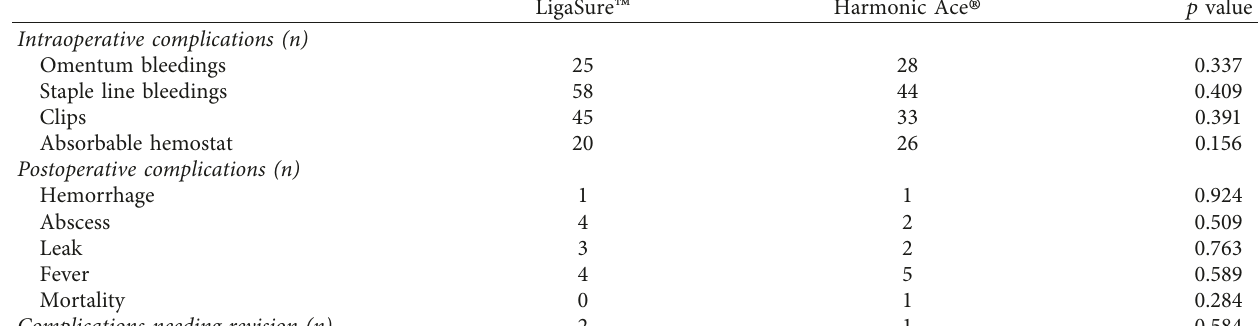
Table 2: Intraoperative and perioperative complications of the patients who underwent laparoscopic sleeve gastrectomy with LigaSure ™ and Harmonic Ace ® .